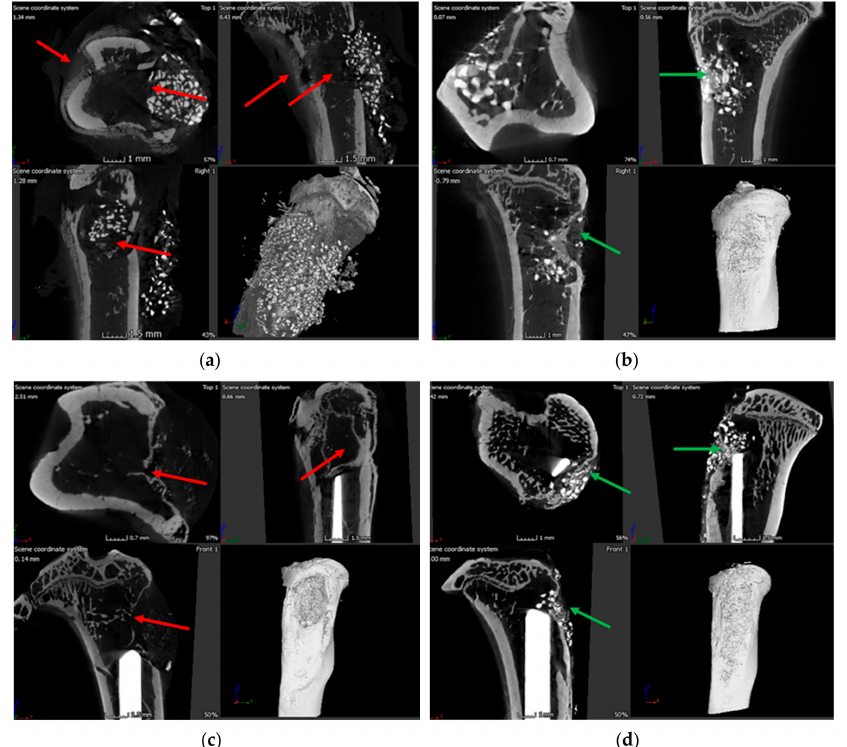
Figure 6. ( a ) The µ -CT images of drill-hole rat control group demonstrated signs of osteomyelitis through signs of infection, decreased bone formation and formation of sinus tract. Infection seemed to have spread to the posterior of the bone. ( b ) The drill-hole treatment group showed no signs of osteomyelitis and the bone appeared to be healed with new bone formation and cortical bone bridging. Bone seemed to be undergoing remodeling. ( c ) The µ -CT images of k-wire rat control group demonstrated signs of osteomyelitis through signs of infection, decreased bone formation and formation of sinus tract. ( d ) The k-wire treatment group showed no signs of osteomyelitis and the bone appeared to be healed with new bone formation. Bone seemed to be undergoing